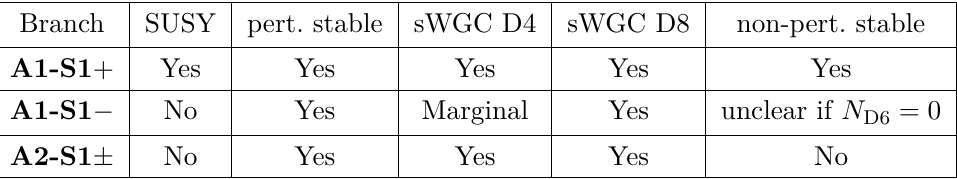
Table 3 . Different branches of vacua, in terms of the sharpened WGC for membranes and their